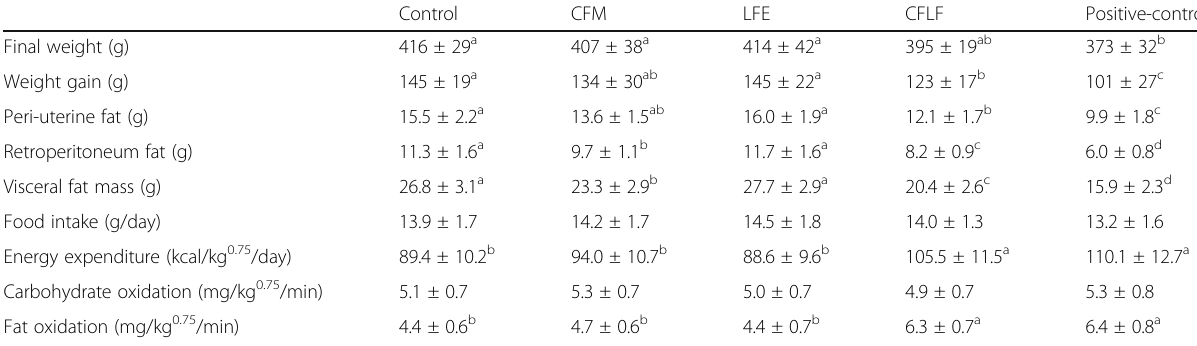
Table 2 Body composition and energy metabolism at the end of experimental periods